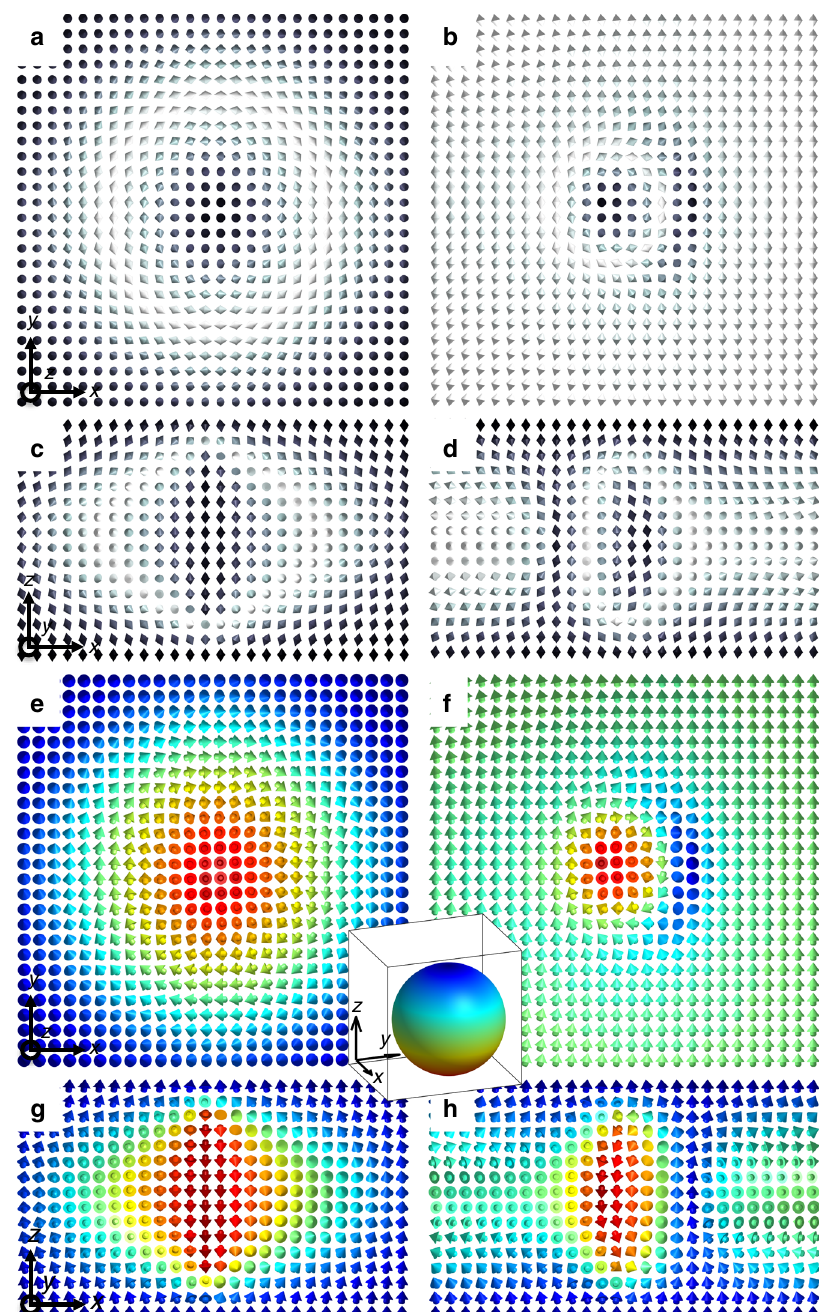
Fig. 3 Three-dimensional structure of baby skyrmions in a con fi ned LC. a , b Director structure of the skyrmion in the cross-sectional plane orthogonal to n 0 for ( a ) U = 0 V and ( b ) U = 4 V presented using double cones locally aligned with their axes along n ( r ). c , d The corresponding director structure of the skyrmion in the cross-sectional plane parallel to n 0 and passing through the skyrmion ’ s center for (c) U = 0 V and (d) U = 4 V. e – h The corresponding director structure of the skyrmion in the ( e , f ) in-plane and ( g , h ) vertical cross-sections visualized using arrows colored according to the corresponding points on S 2 (inset) and to the coloring scheme also used in Fig.